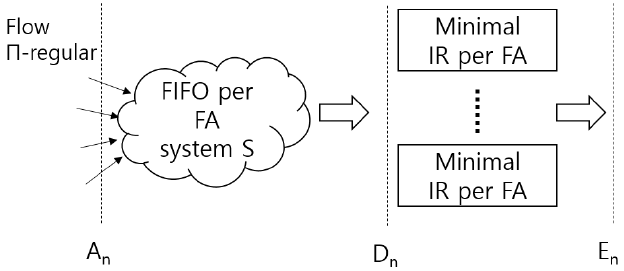
Figure 3. Proposed combined system of a FIFO system per flow aggregate (FA) and minimal IRs.